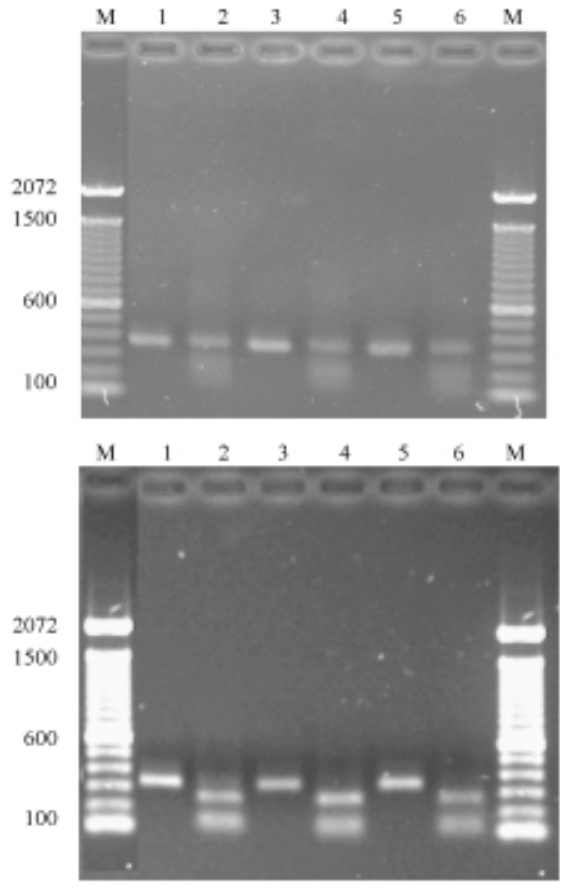
Figure 2 - Ethidium Bromide stained electrophoretic profile of the di- gested and undigested 350 Kb SCAR fragment from SCAR marker P286- 350 = resistant line 11 (samples 1 and 2), susceptible line 165 (samples 3 and 4) and resistant line “labelle”(samples 5 and 6). M = 100 base-pair marker. Samples 1,3 and 5 are from the undigested SCAR fragment while samples 2,4 and 6 were Alu I-digested (A) and Hae -digested